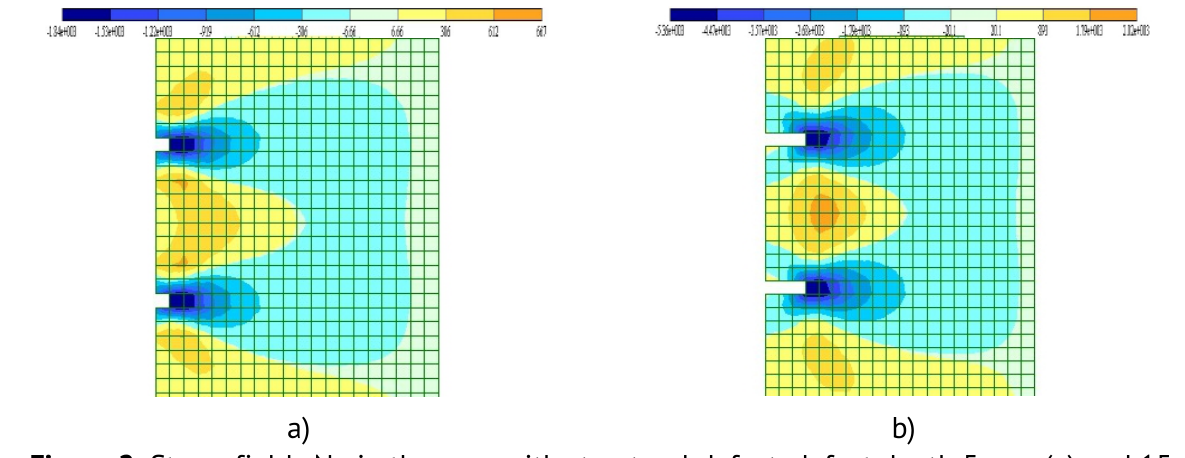
Figure 2. Stress fields Nx in the area with structural defect: defect depth 5 mm (а) and 15 mm (b) for concrete grade С16/20 under stress in concrete